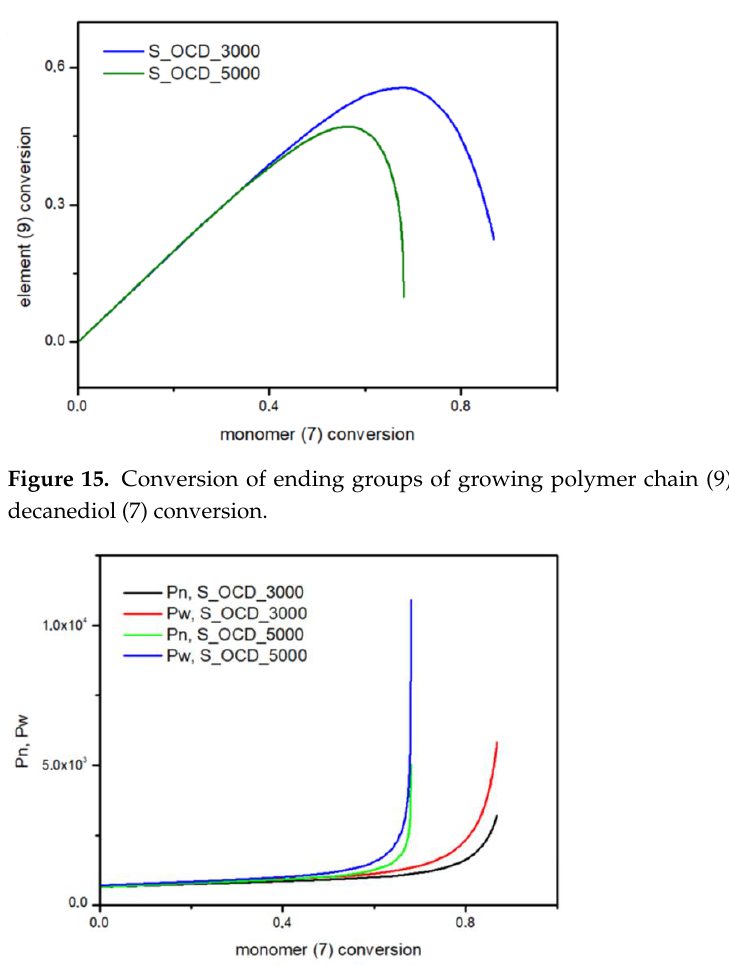
Figure 17. Dispersity (P w /P n ) as a function of the conversion of 1,10-decanediol added in the second stage of the synthesis. Figure 18. Comparison of the molar mass distributions obtained from MALDI-TOF traces for E_OCD_3000 and DLL simulations for S_OCD_3000, S_OCD_5000. 3.5.3. Urethane Prepolymers In the next stage, the OCDs obtained in the previous step were reacted with different molar excesses of IPDI. The result of this process is the creation of prepolymer materials.